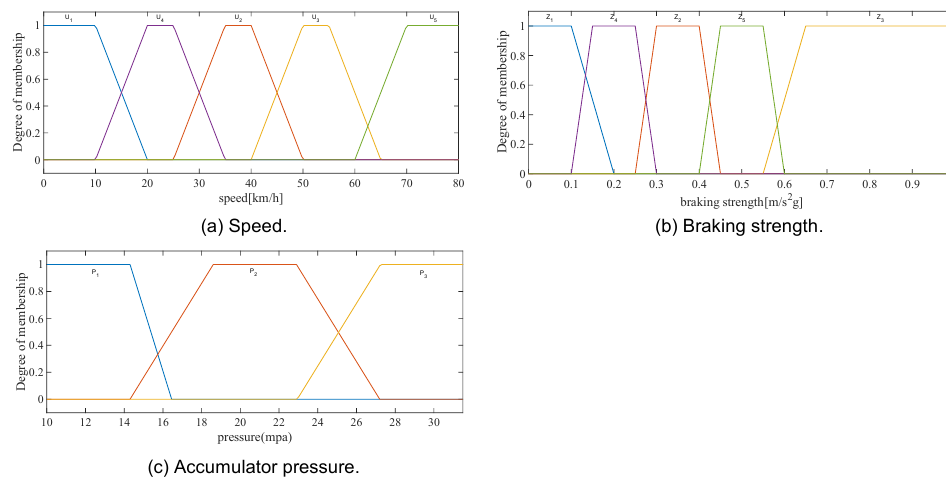
Figure 4. The fuzzy partition: ( a ) speed; ( b ) braking strength; ( c ) accumulator state of charge. The FIS will be improved using the QL method to obtain better performance.